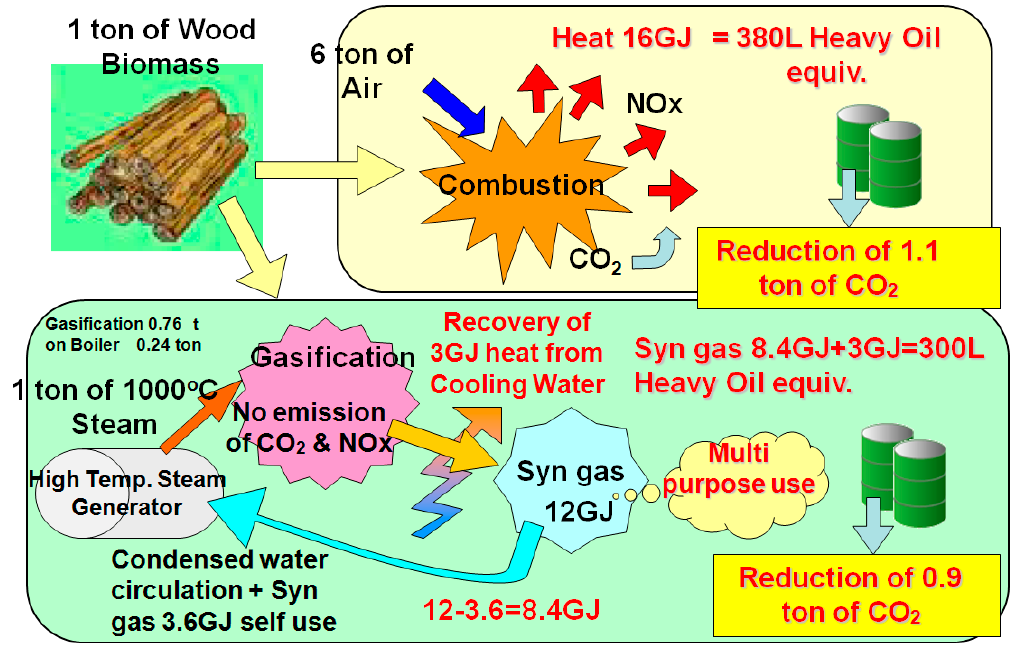
Figure 16. Example of effective utilization of biomass energy (Combustion and Gasification). Comparison of two methods: direct combustion ( top ) and gasification ( bottom ) shows a significant reduction of harmful pollutants.